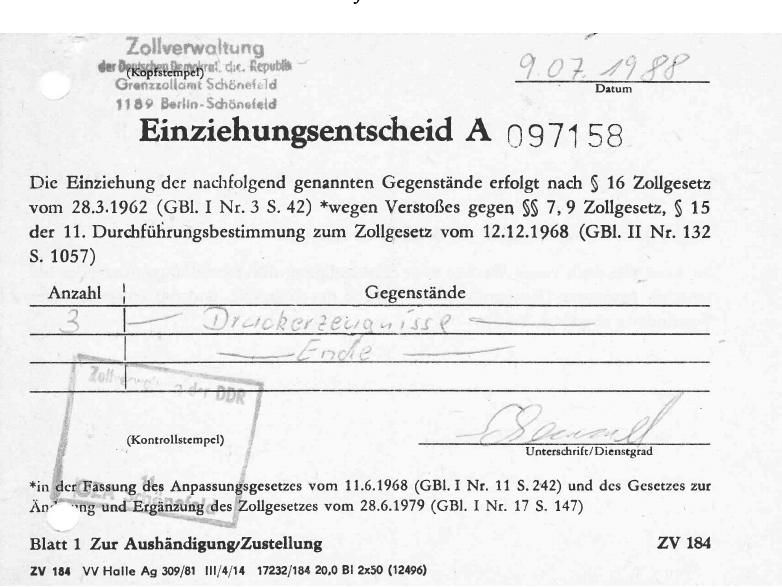
Figure 1: Form confirming that publications were